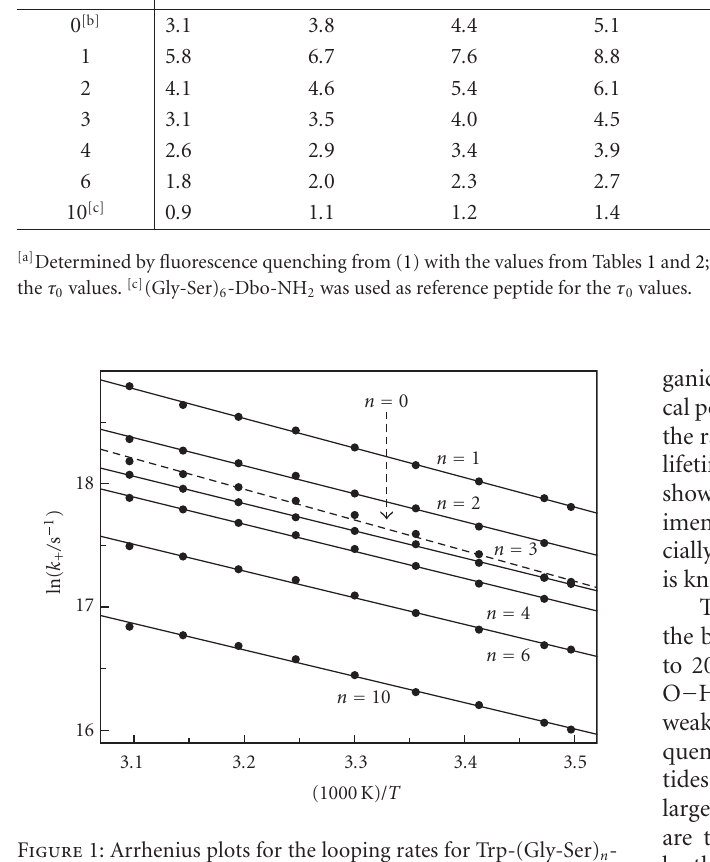
Figure 1: Arrhenius plots for the looping rates for Trp-(Gly-Ser) n - Dbo-NH 2 peptides in D 2 O; note that the dashed line refers to the shortest peptide ( n = 0), which shows exceptional behavior (see